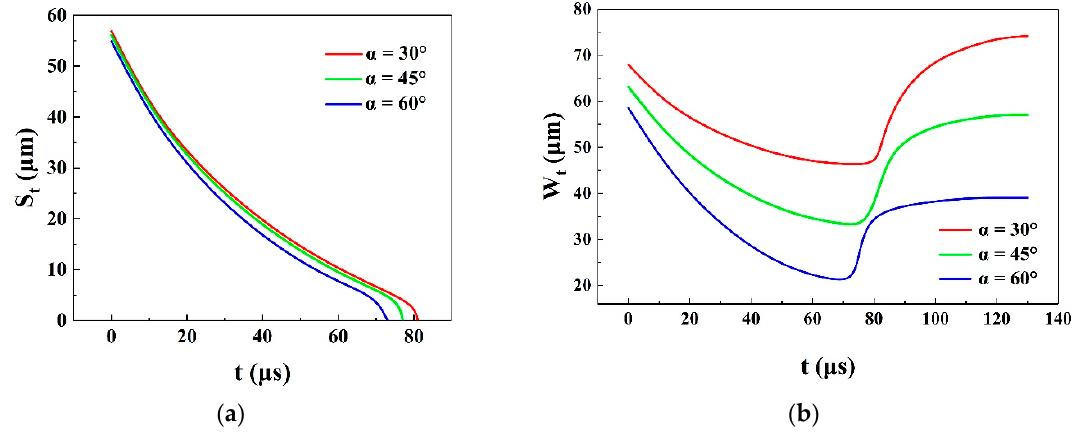
Figure 5. The change trend of ( a ) the thickness of the thinnest part of the liquid filament and ( b ) the width of the contact line on the upper plate with time.